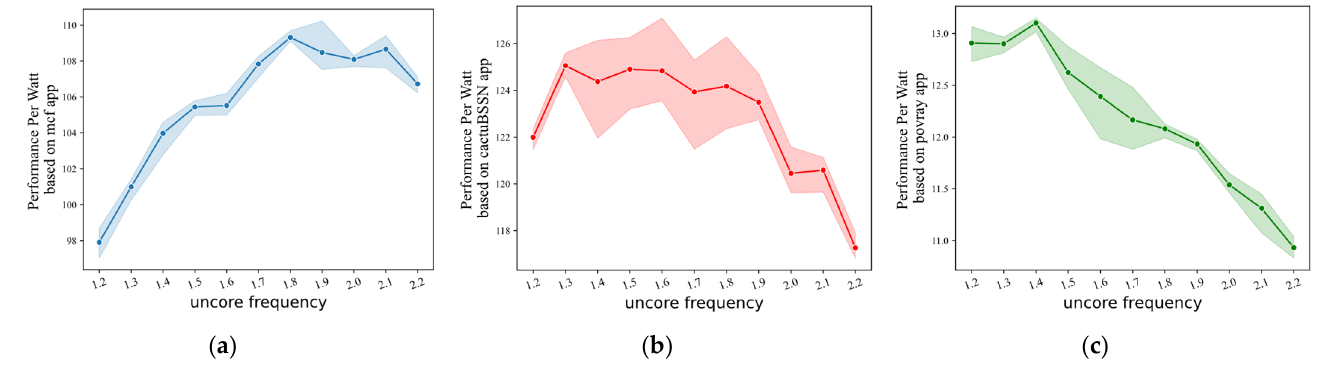
Figure 1. Impact of uncore frequency on processor PPW for different benchmark apps: ( a ) mcf; ( b ) cactuBSSN; ( c ) povray. The shading in each subplot indicates the fluctuating range of PPW values at different uncore frequencies.